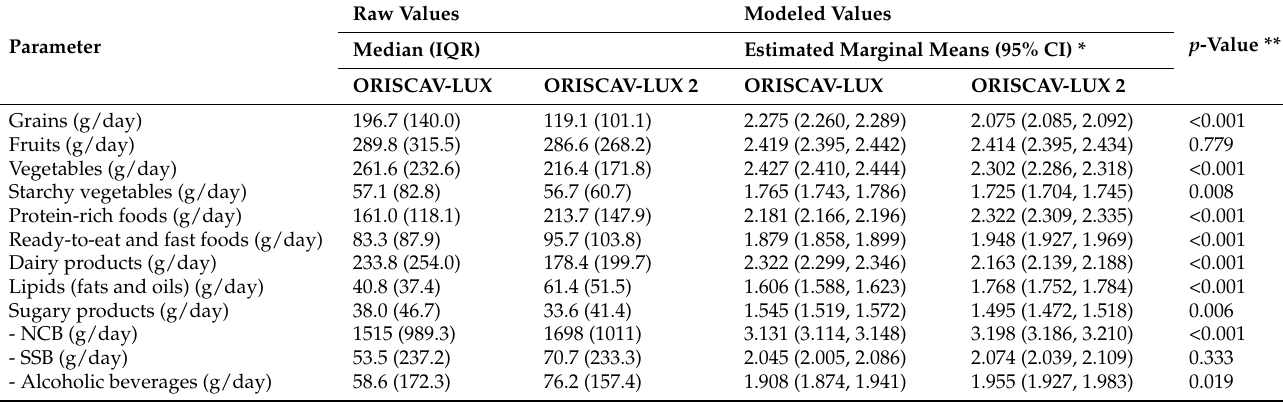
Table 4. Median (interquartile range) and estimated marginal means of food group intake of participants ( p -values are based on linear mixed models, as explained in